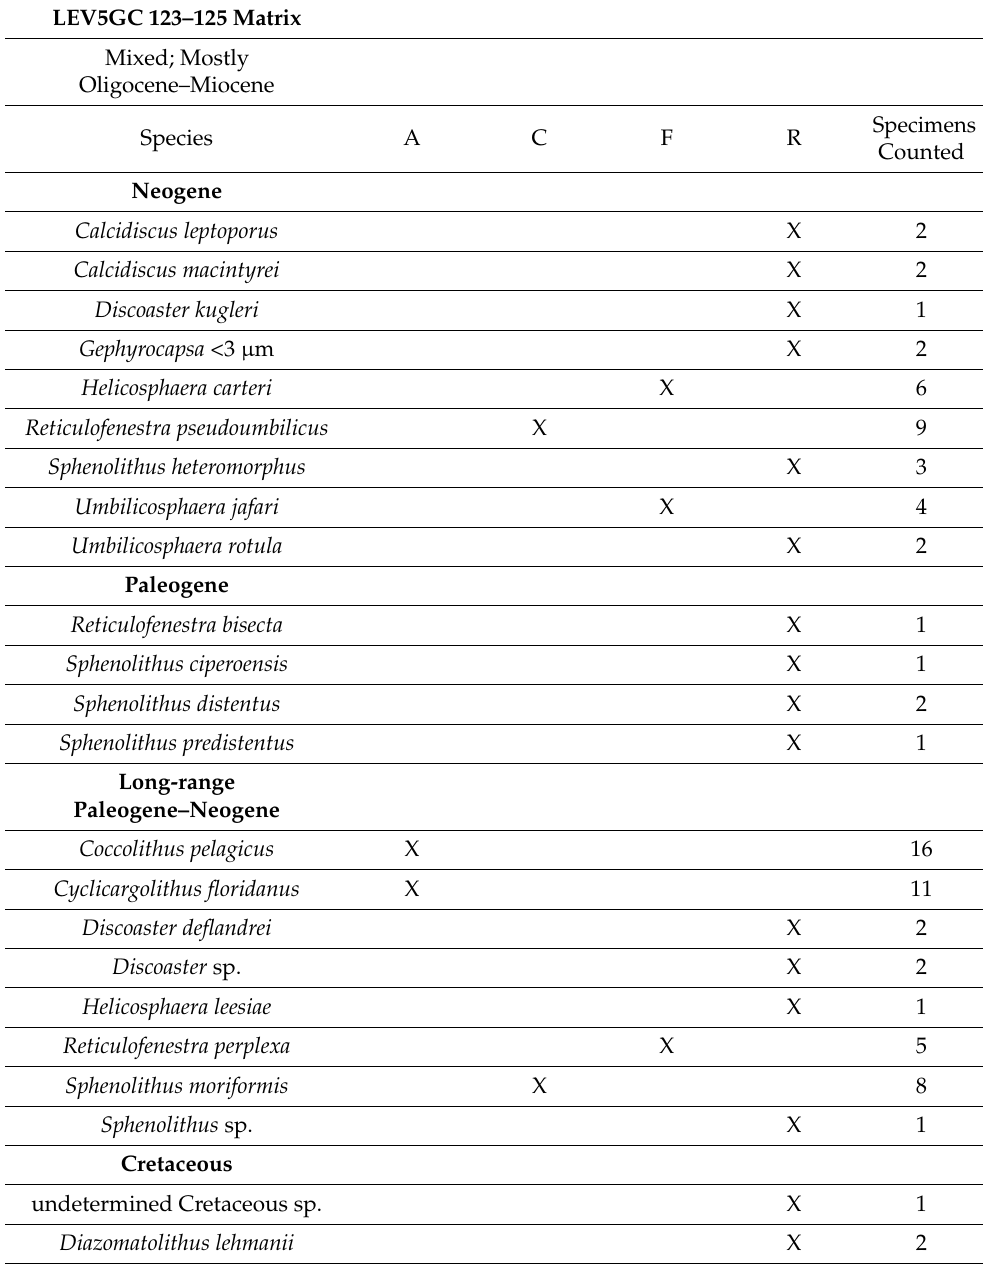
Table A26. Moscow MV.